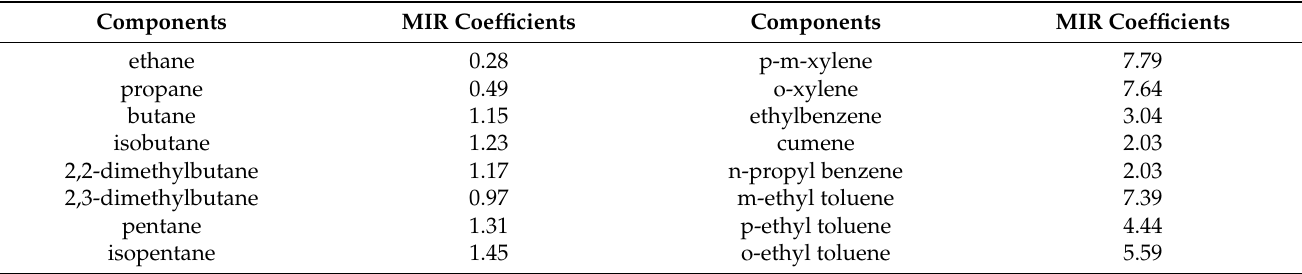
Table 3. MIR coefficients of VOCs for OFP